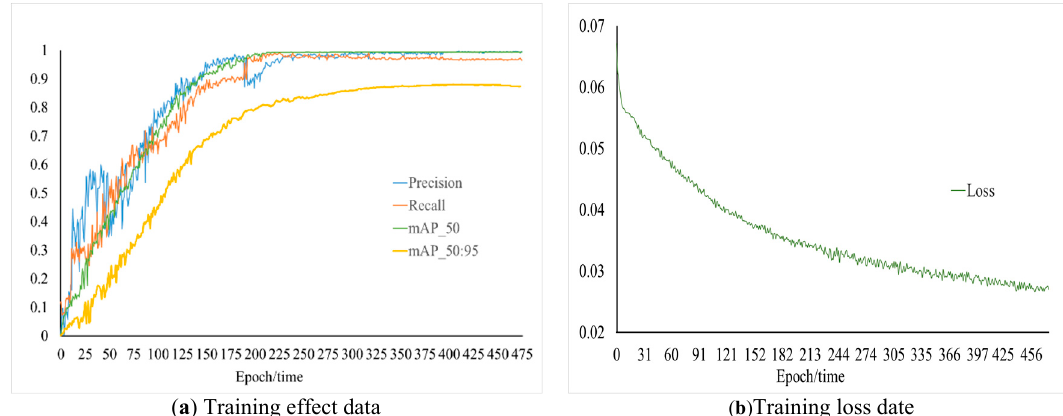
Figure 8. Training results.